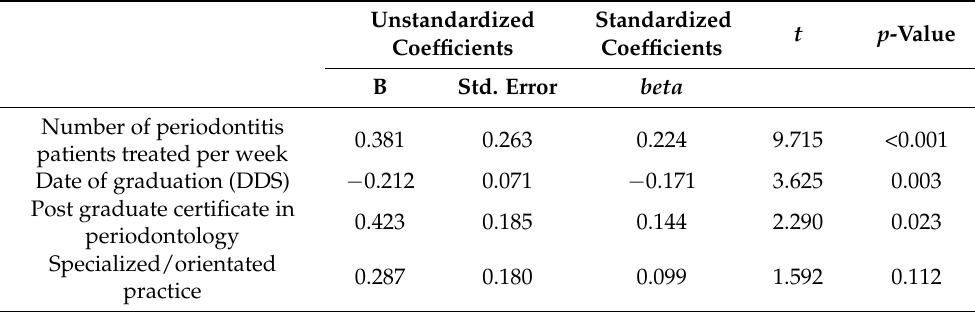
Table 4. Factors associated with higher knowledge score about